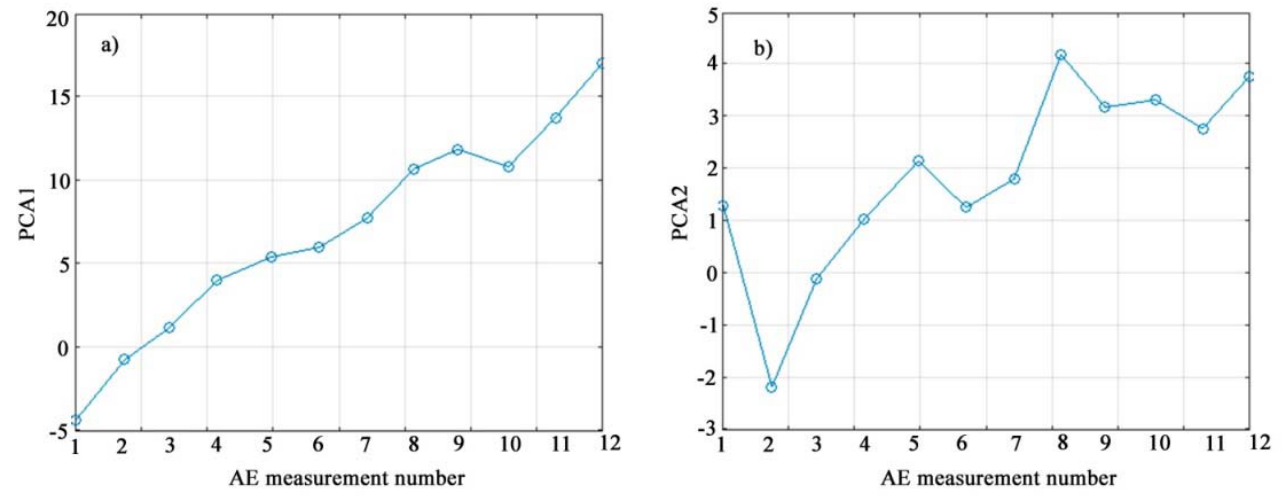
Figure 12. The first ( a ) and second ( b ) principal components for sequentially recorded AE signals during bending tests.